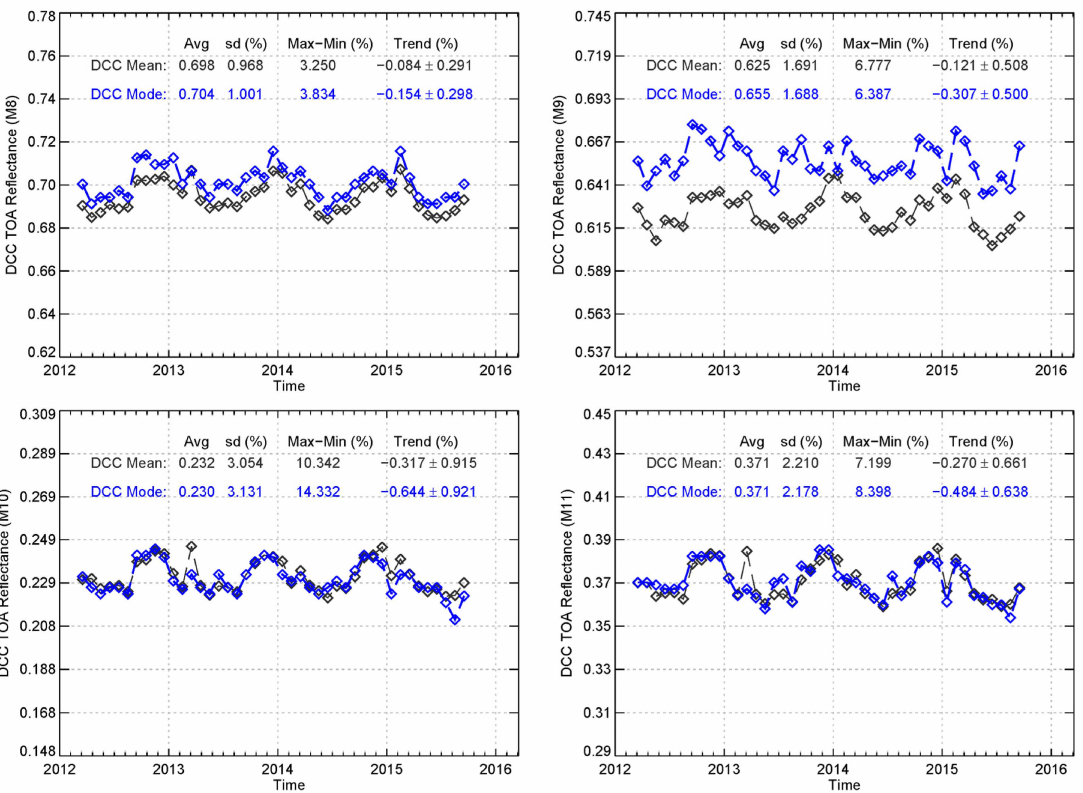
Figure 11. Monthly DCC mode and mean time series for SWIR bands (M8–M11).